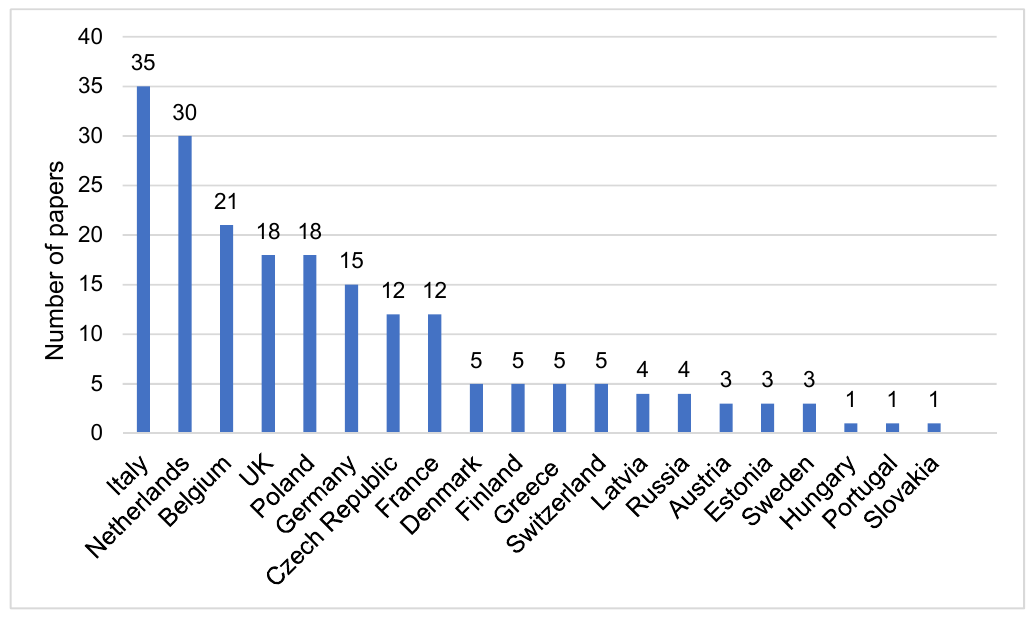
Figure 2. The number of research papers on the yellow mealworm published in different European countries between 2012 and 2020.